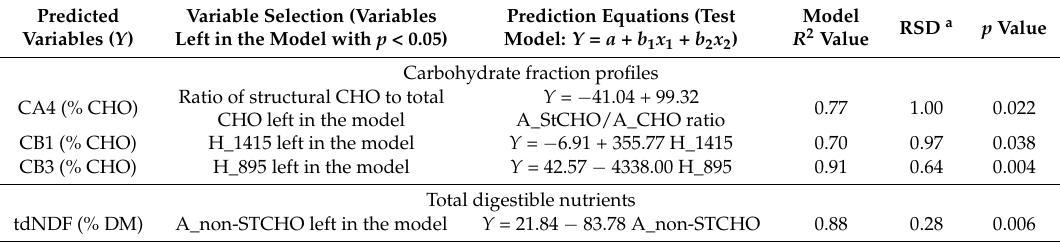
Table 5. Multiple regression analysis to choose the most important CHO spectral parameters to predict CHO nutrient supply from the alfalfa forage ( Medicago sativa spp. Sativa